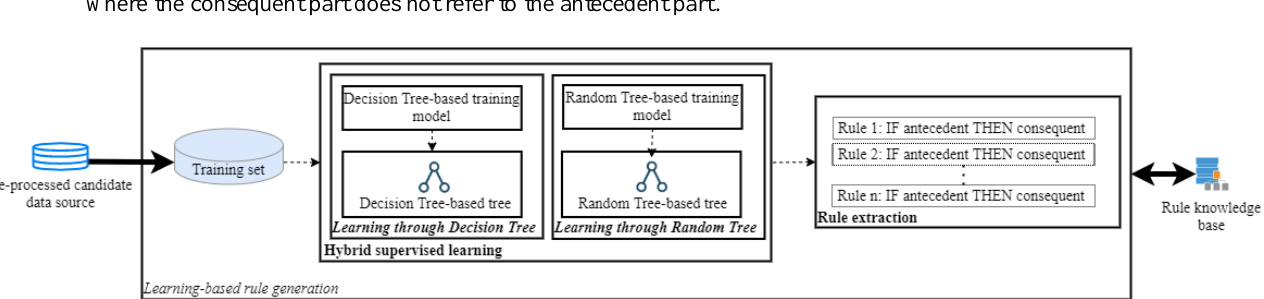
Figure 3. Learning-based rule generation phase